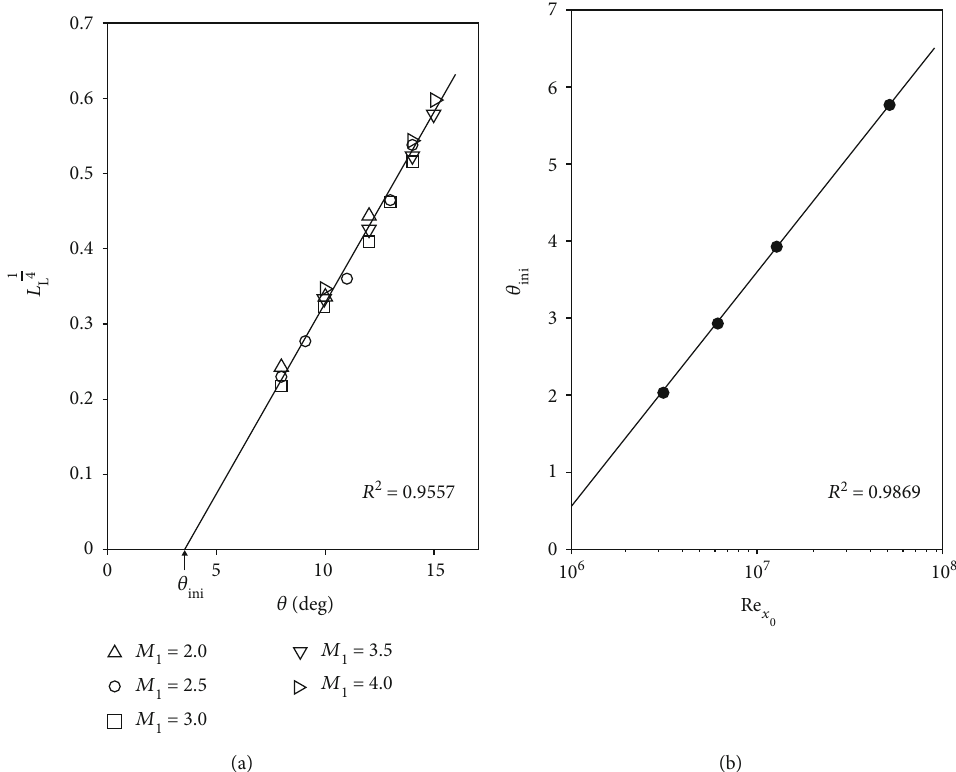
≤ 4 ): (a) in fl uence of the fl ow de fl ection angle on the separation length and (b) 1